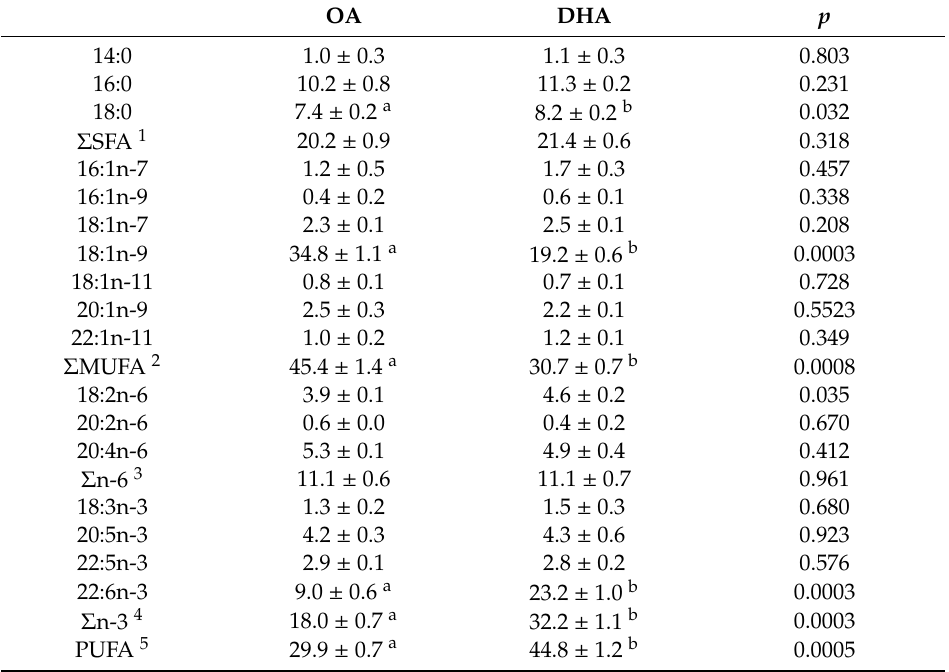
Table 1. Fatty acid composition (% of total) in mature Atlantic salmon adipocytes. Differentiated cells at day 9 were incubated with oleic (OA) or docosahexaenoic acid (DHA) for 6 days (mean ± SEM; n = 3).